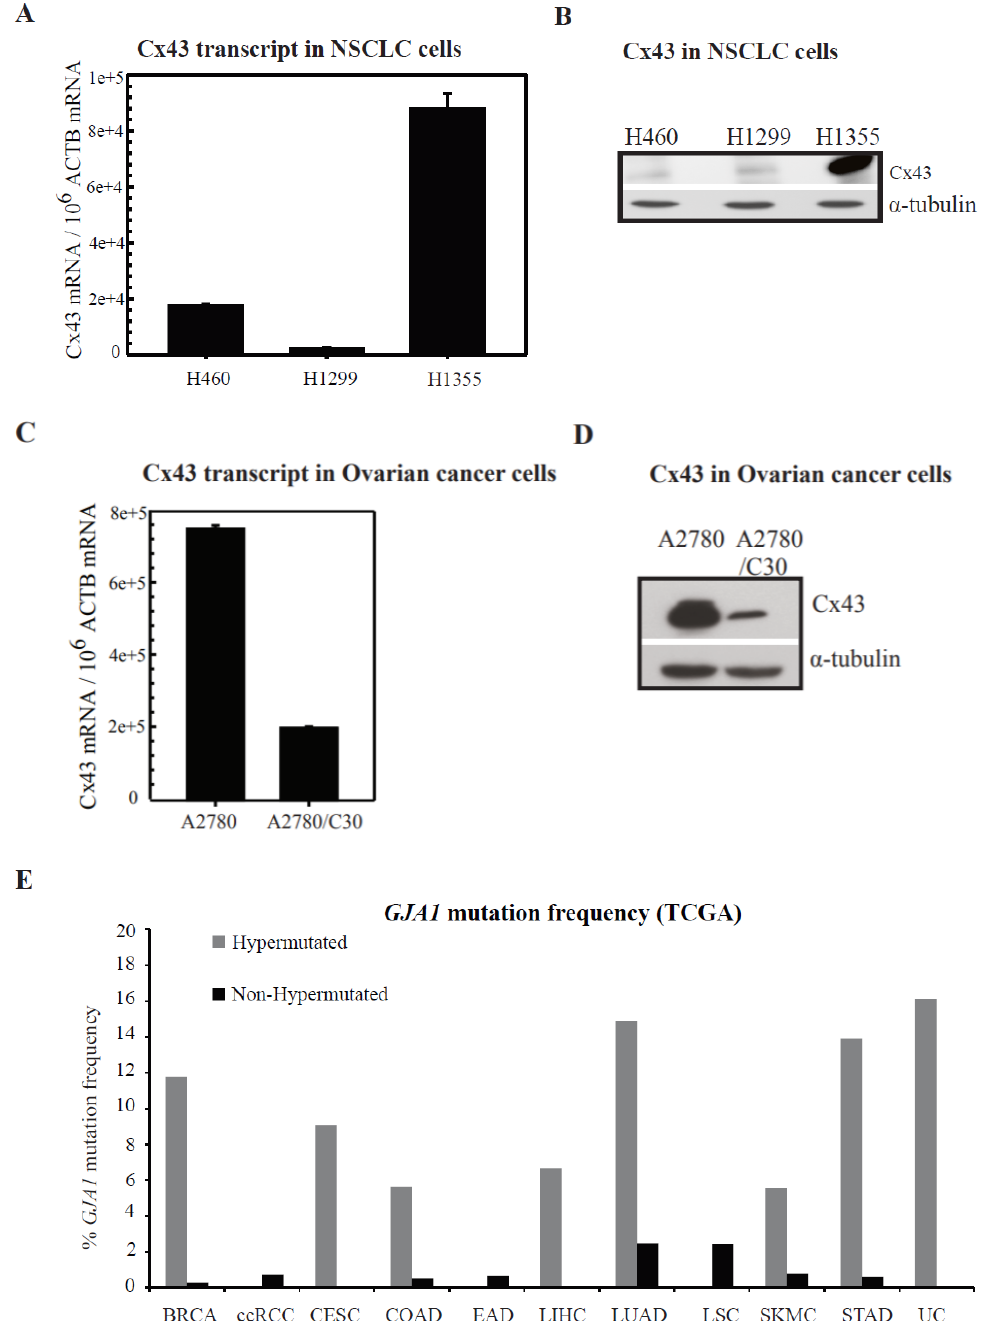
Figure 2. Figure 2. Cont.